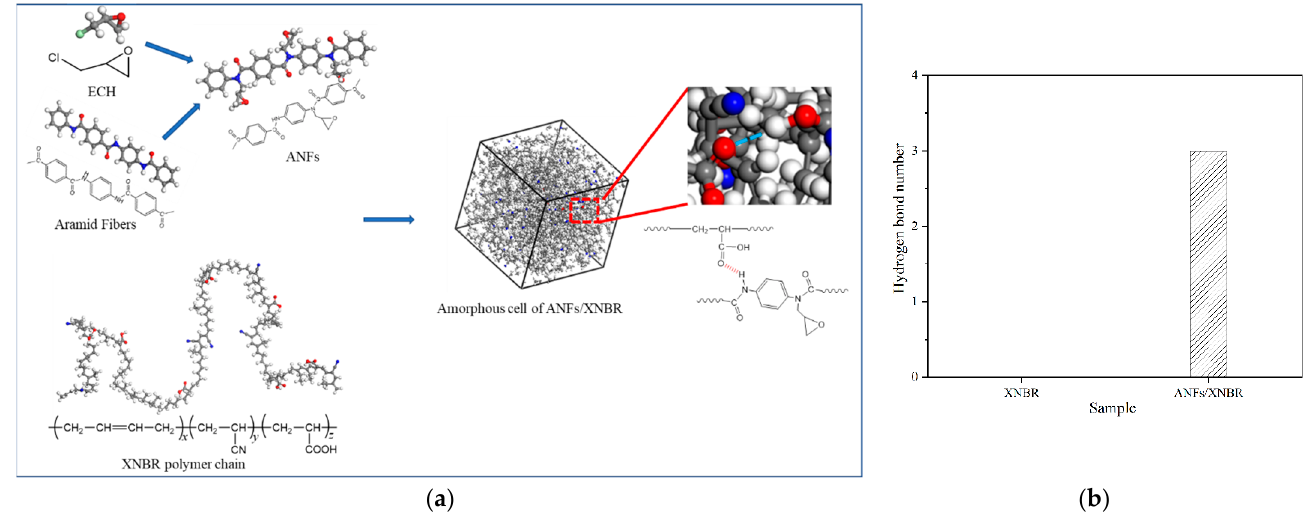
Figure 1. ( a ) Constructs of the nanocomposites models (the gray spheres are carbon atoms, the white spheres are hydrogen atoms, the blue spheres are nitrogen atoms, and the red spheres are oxygen atoms), and ( b ) the number of intermolecular hydrogen bonds.